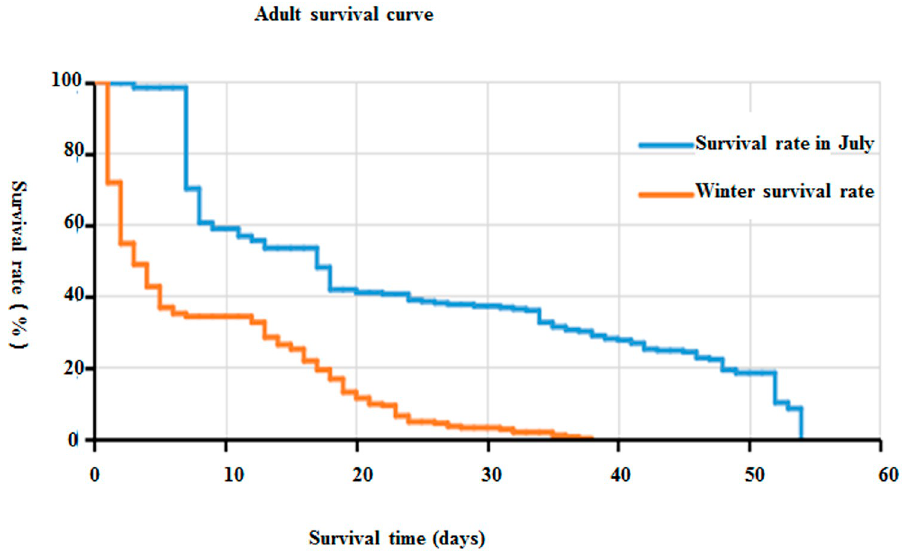
Fig 6. Survival curve of adult Ae albopictus